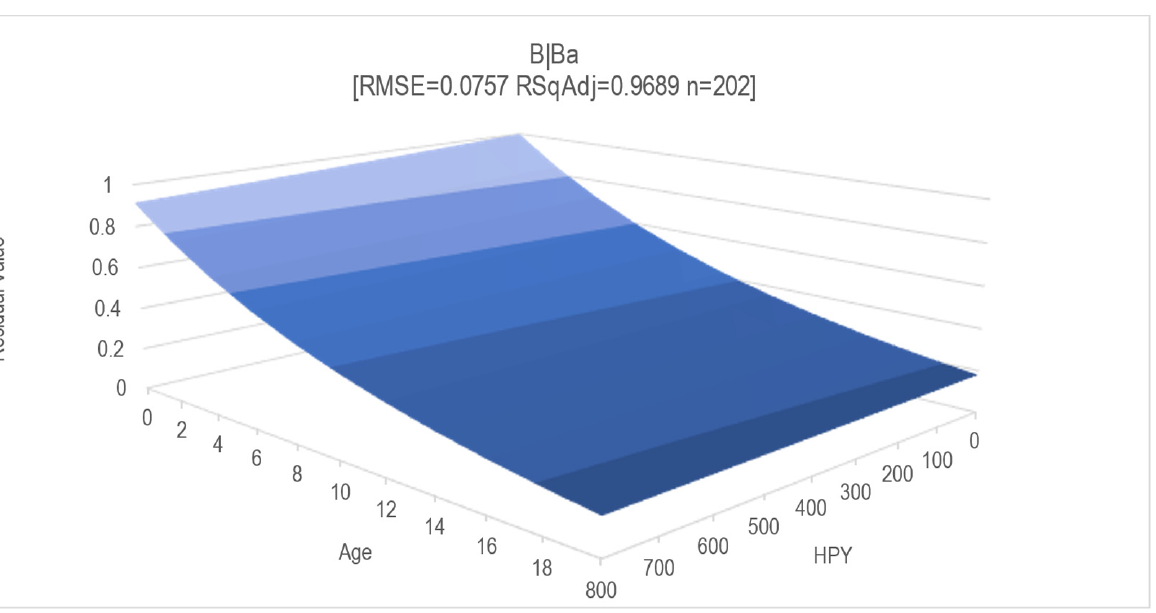
Figure 7. Proposed residual value power linear regression for combine family B|Ba.